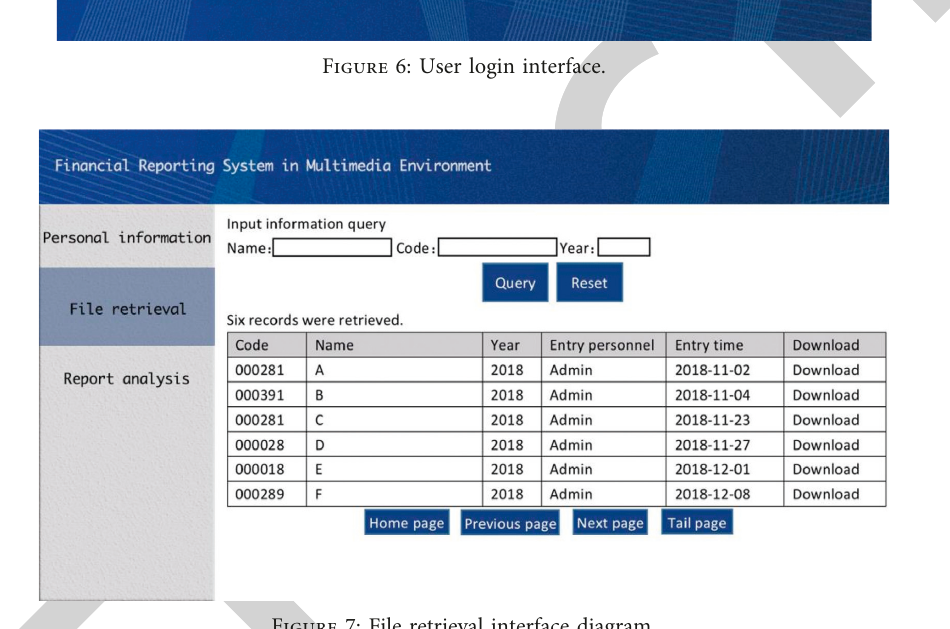
Figure 7: File retrieval interface